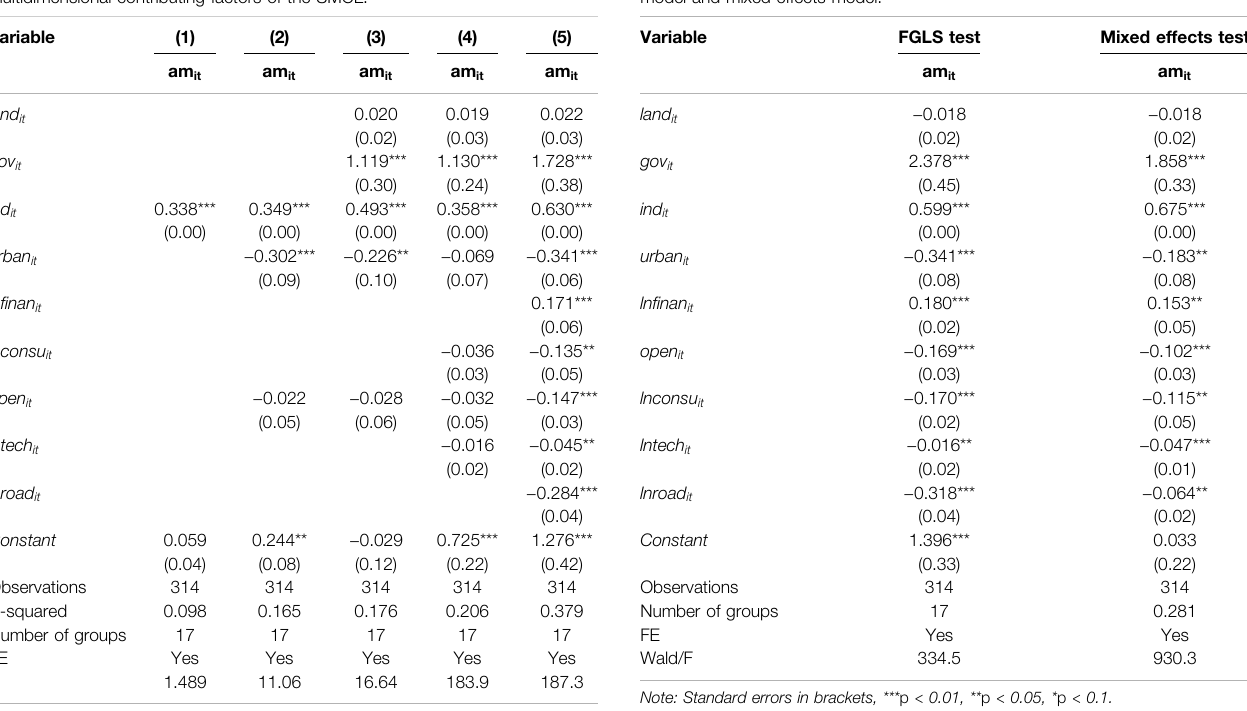
TABLE 7 | Robustness test of the econometric regression results via the FGLS model and mixed effects